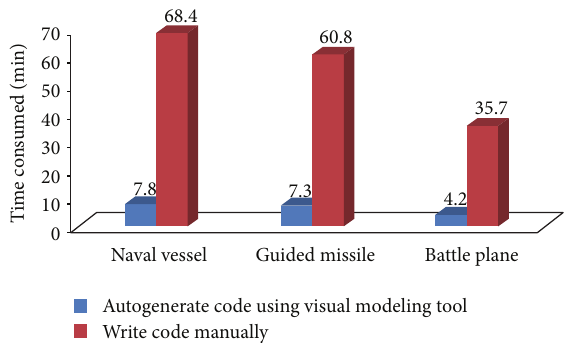
Figure 10: Time consumed of two approaches for developing three simulation entities.